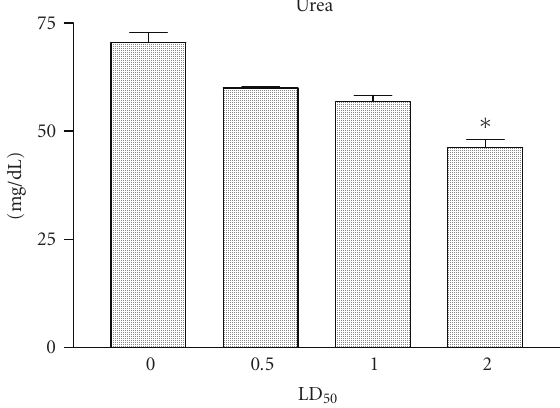
Figure 2: Glucose determination . Groups of female mice from the BALB/c strain, 13–15 g of body weight, were injected i.p. with 0.5, or 1, and/or 2 LD 50 of Cdt. After 2 hours the mice were bled and the levels of glucose present in sera from mice injected were determined. Each vertical bar represents the mean plus or minus the standard deviation value of samples from the results obtained with two experiments carried out with two independent groups of five mice each. Statistical di ff erences between the injections were marked with asterisk ( P < . 01).